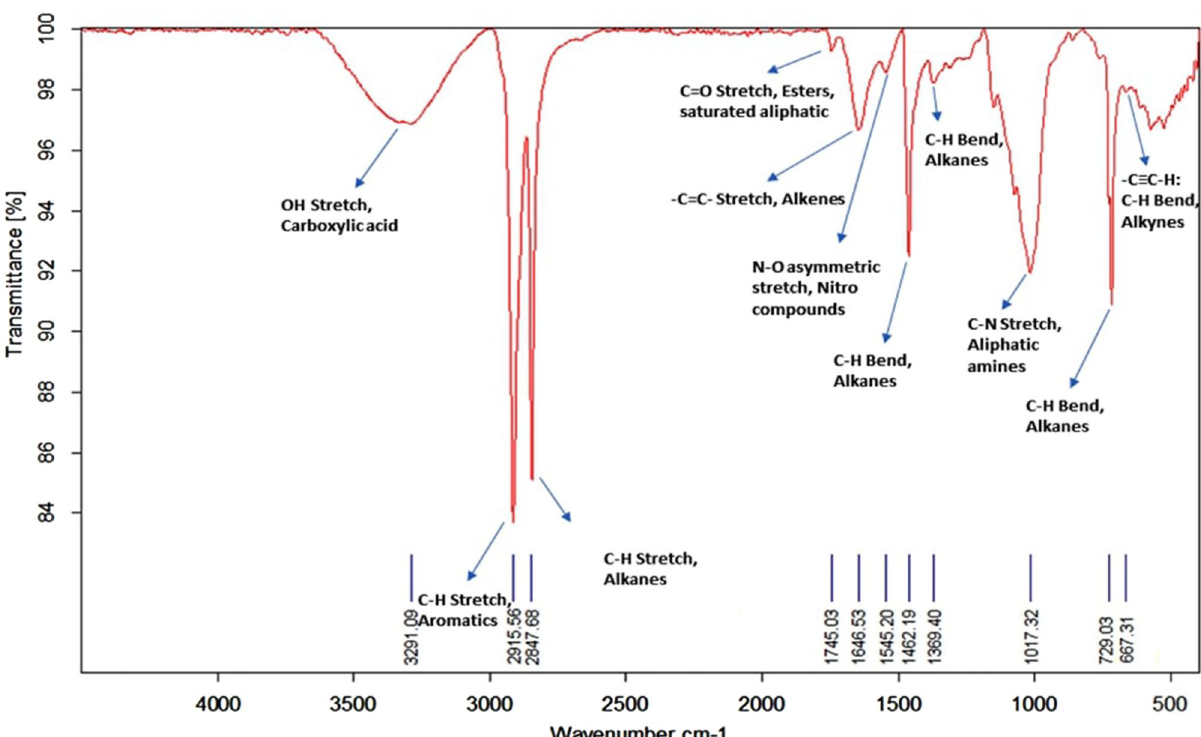
Figure 16. FT-IR spectrometry results of microalga ( Uronema africanum ) treated LDPE